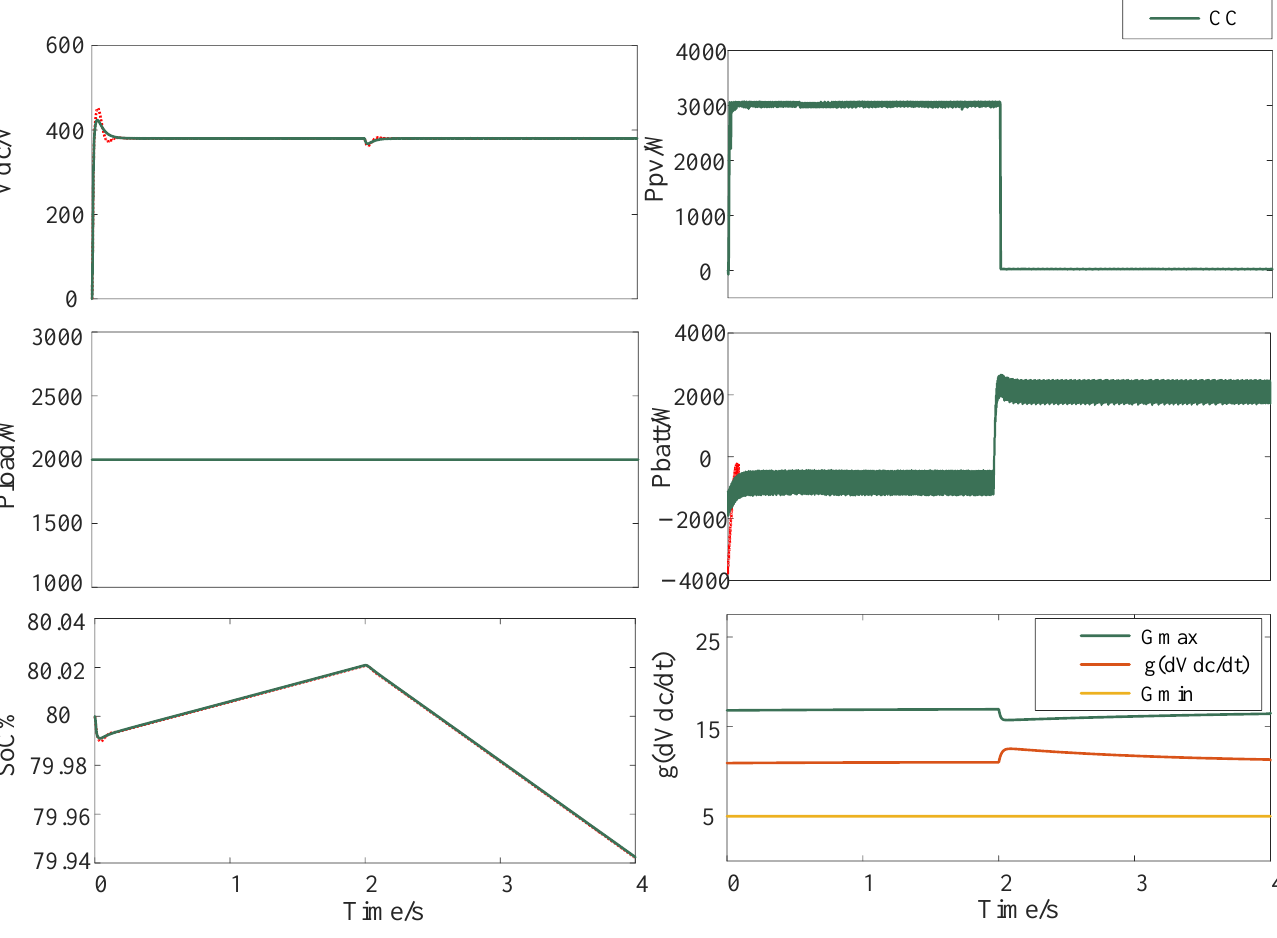
Figure 7. Simulation under the condition involving out-of-operation PV failure.